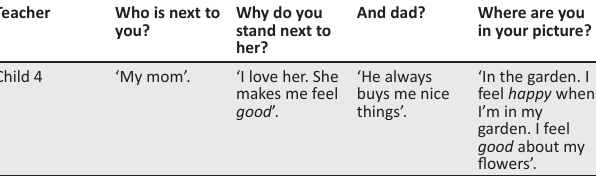
TABLE 1: Child 4’s narratives.